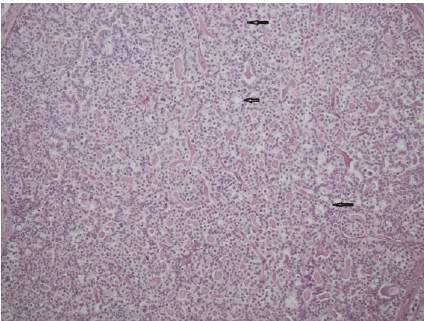
Figure 3: Histological section of the tumor. Adult granulosa cell tumor with microfollicular pattern. Call-Exner body: coffee bean- like tumor cells with groove core notches surrounding glandular cavities containing eosinophilic material and tumor cells detached from the dressing (arrows). Hematoxylin-eosin stain, 10x magnifi- cation.